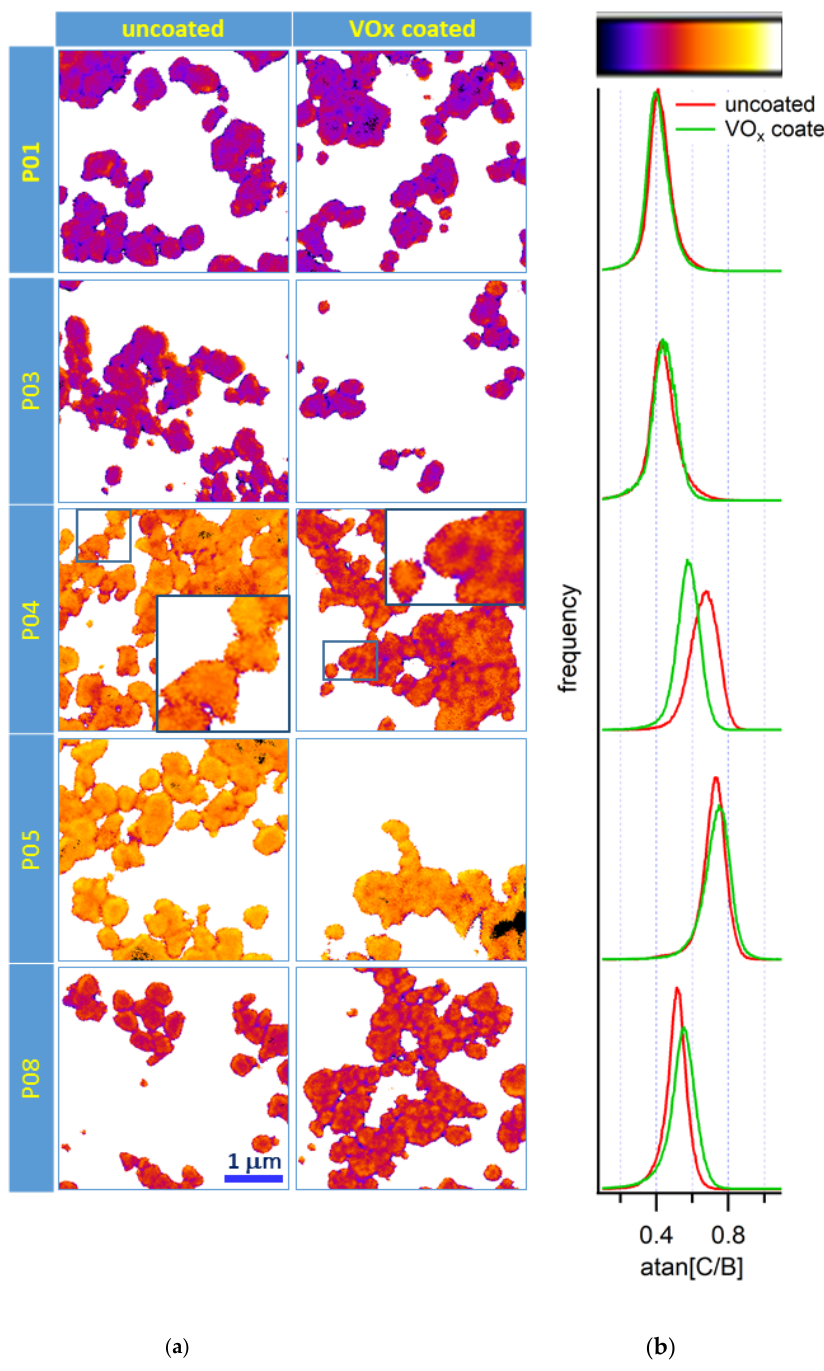
Figure 4. Distributions of C vs. B components, represented as arctan(C/B) , in the O-K absorption of ( a ) 2D-maps; ( b ) corresponding area-normalized histograms. Regions of high absorbance have been masked in black to avoid consideration of possible artifacts. Insets in P04 show a detail at increased magnification.